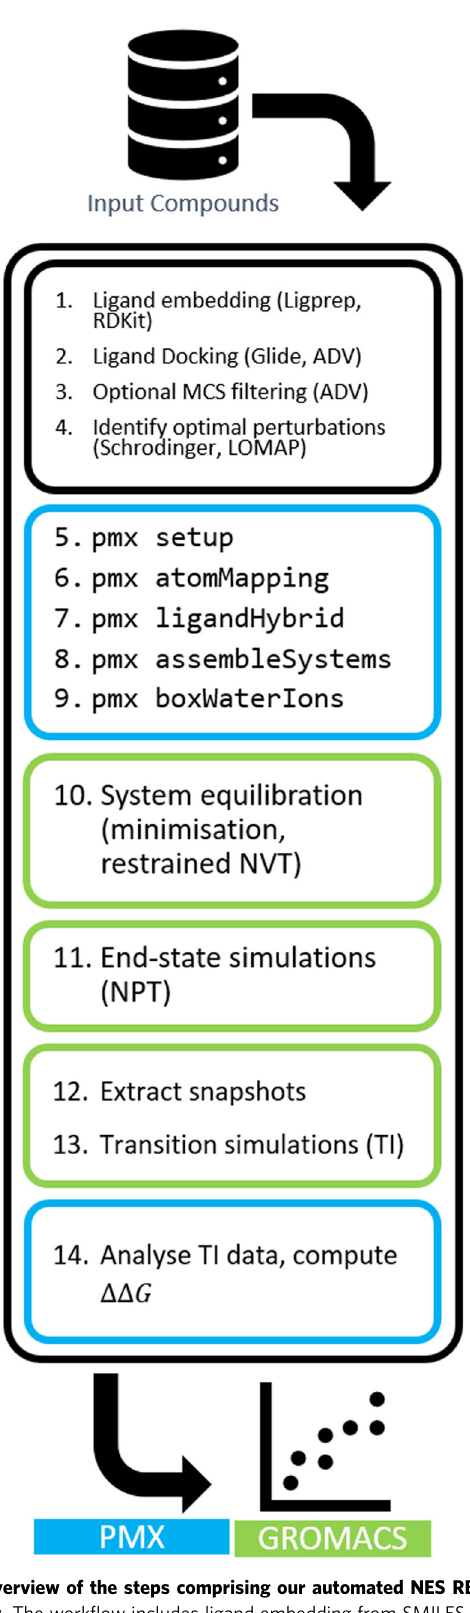
Fig. 8 Overview of the steps comprising our automated NES RBFE work fl ow. The work fl ow includes ligand embedding from SMILES, docking, topology preparation, simulation and analysis